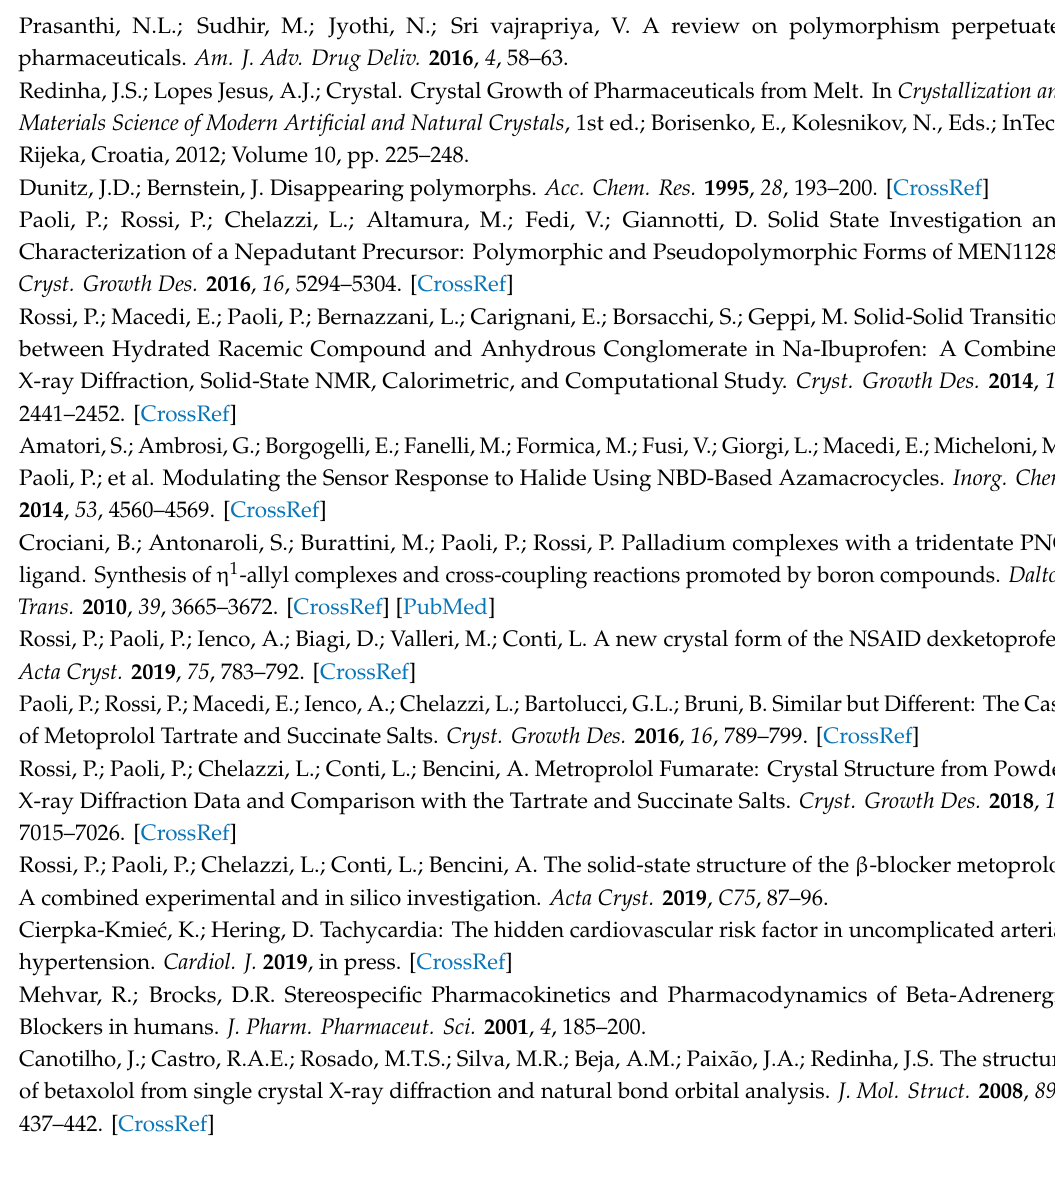
Table S1: Cell parameters of BE_IV at 200 and 300 K; Table S2: Selected dihedral angles of BE_I and BE_IV (S enantiomer); Table S3: Selected intermolecular interactions in BE_I (ROKNUB refcode in the Cambridge Structural Database); Table S4. Intermolecular interaction energies; Scheme S1: Dihedral angles definition for the ethanolamine fragment; Scheme S2: Fragment searched in the CSD for the R4,4(8) pattern; Figure S1: Superimposition of the betaxolol molecule in BE_IV at 100 (blue), 200 (green) and 300 K (pink). Figure S2: Double configuration of the cyclopropylmethoxy fragment; Figures S3 and S4: Views of the crystal packing of BE_IV . Figure S5: View of the crystal packing of BE_IV along the c axis direction highlighting the zig-zag arrangement of the alternating R and S betaxolol molecules within each chain. For sake of clarity for cyclopropylmethoxy the model having the highest occupancy factor was